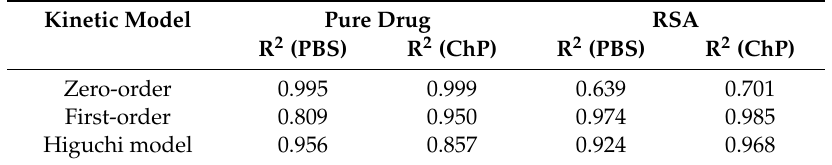
Figure 7. Fitting of released data of RSA in phosphate-buffered solution (pH = 7.4) ( a ) and simulated gastric fluid (pH = 2.0) ( b ) at 37 °C to three different models: zero-order, first-order, and Higuchi model.